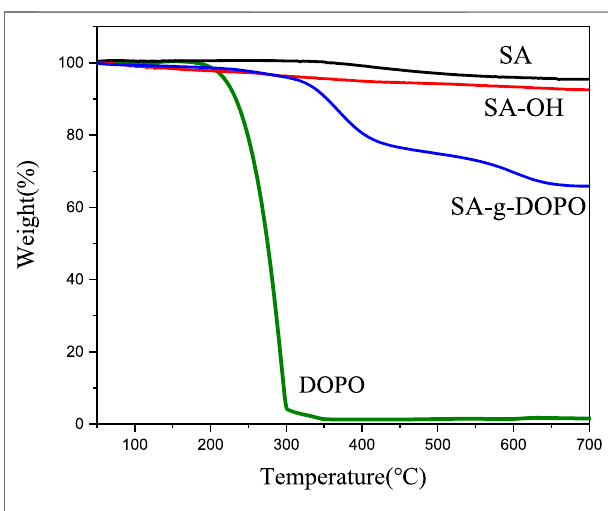
FIGURE 6 | TGA curves for SA, SA-OH, SA-g-DOPO and